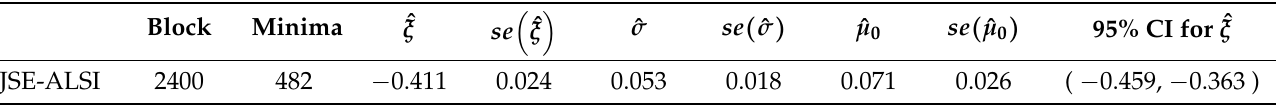
Table 3. Naive Bayesian Estimates for Generalised Extreme Value Distribution